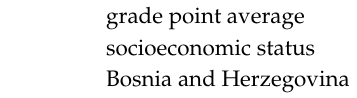
Figure S1: Prevalence of illicit drug misuse at study baseline and follow-up, Table S1: Attrition bias analysis between responders and non-responders on a basis of illicit drug use at baseline and